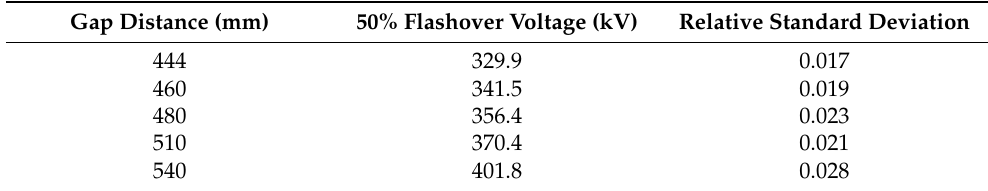
Table 3. The 50% lightning impulse flashover voltage of parallel gap.